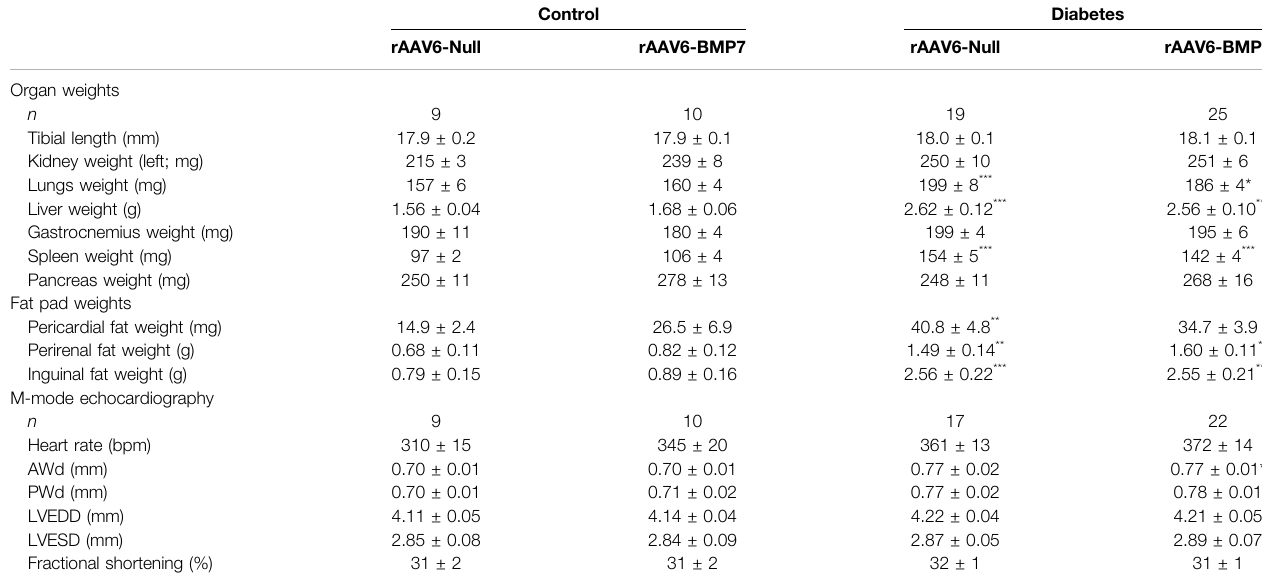
TABLE 1 | Organ weights and systolic heart function in control and diabetic mice following rAAV6-BMP7 or rAAV6-Null